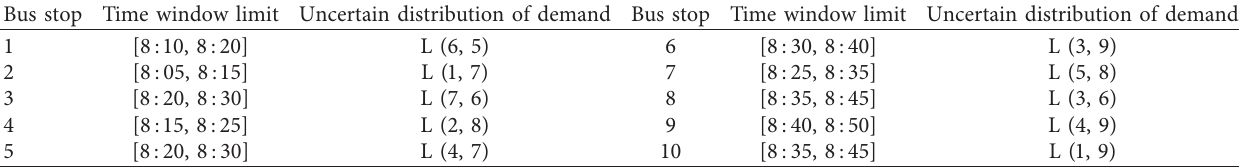
Table 2: Time windows and requirements of passengers at different stops.